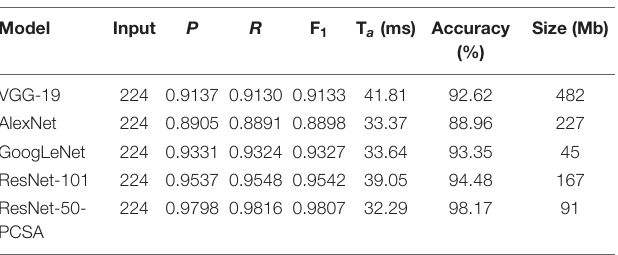
TABLE 6 | Accuracy for crop pest recognition with 10 classes.